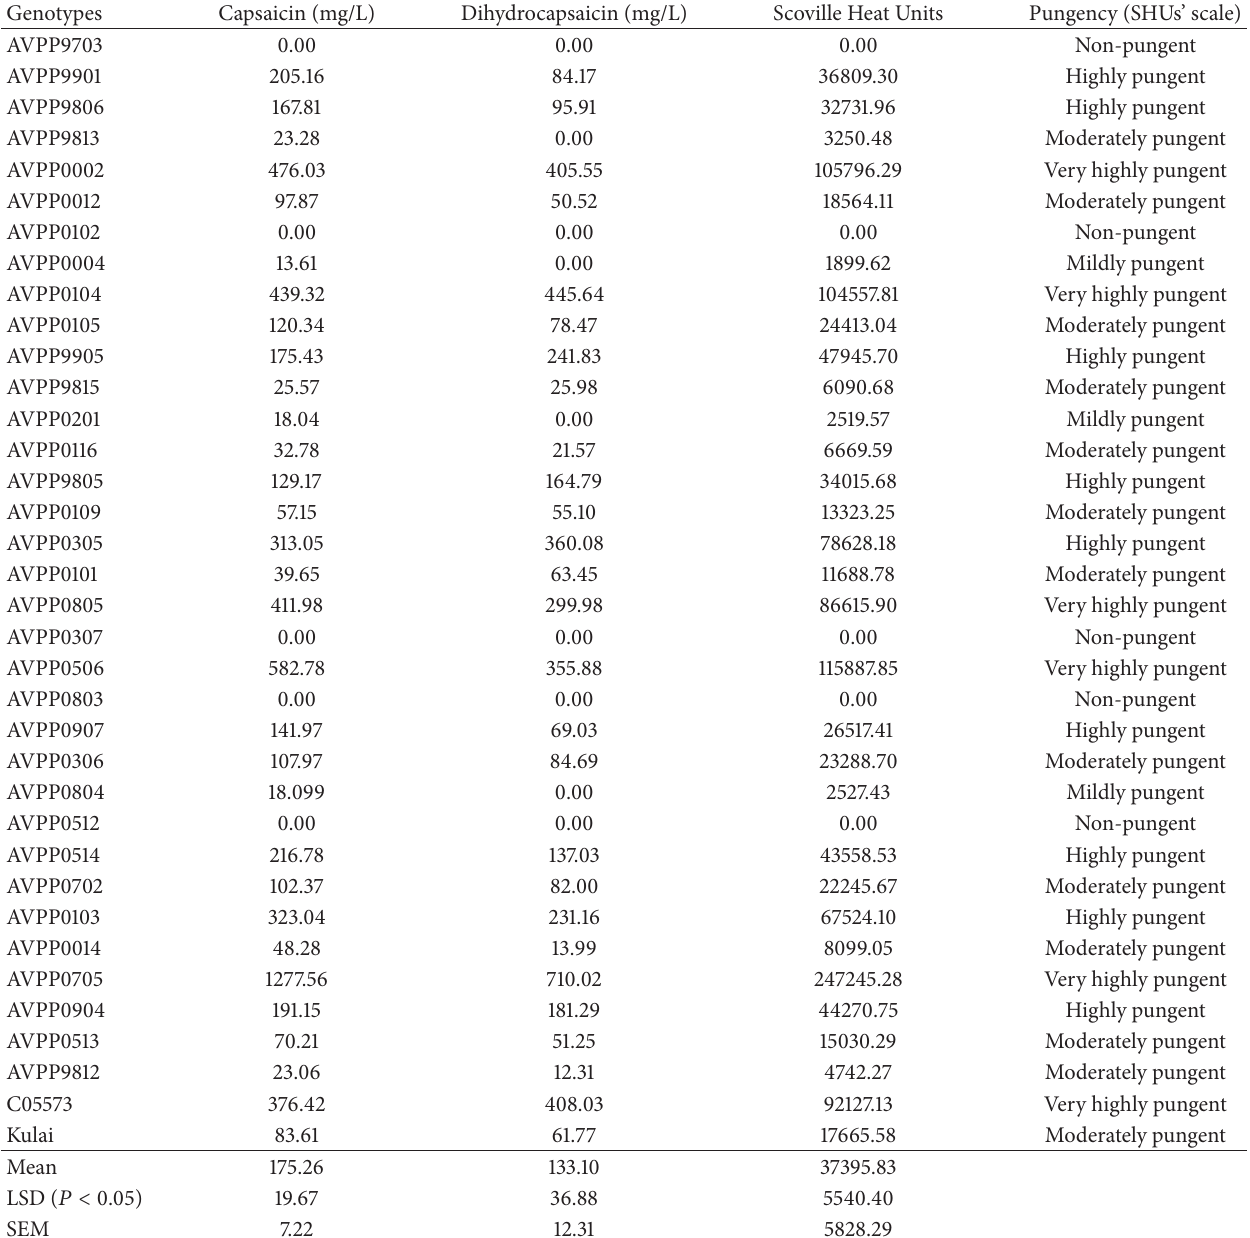
Table 6: The capsaicins and dihydrocapsaicin content of the thirty-six chili pepper genotype samples